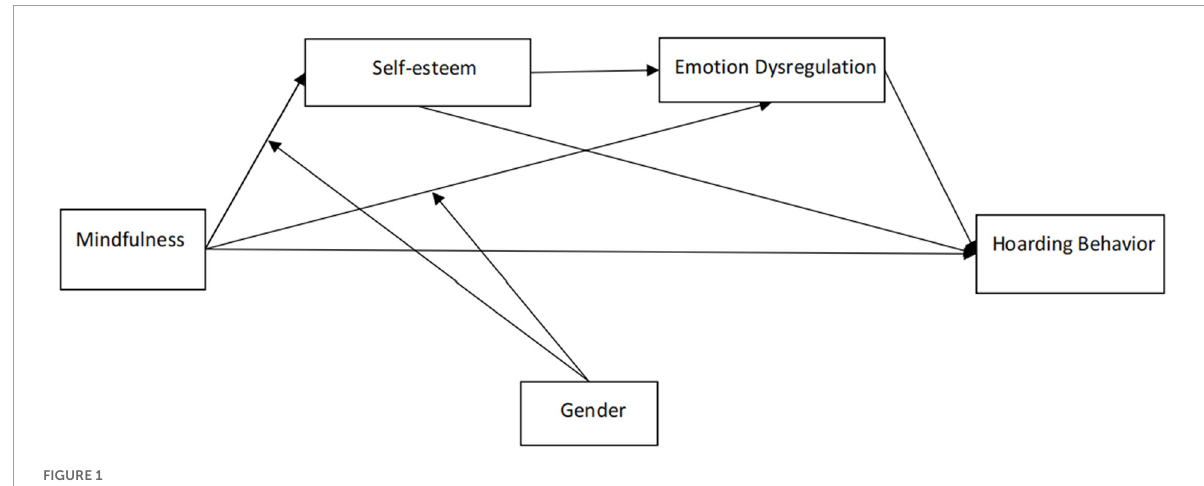
FIGURE1 Overview of the proposed moderated multi-mediation model.